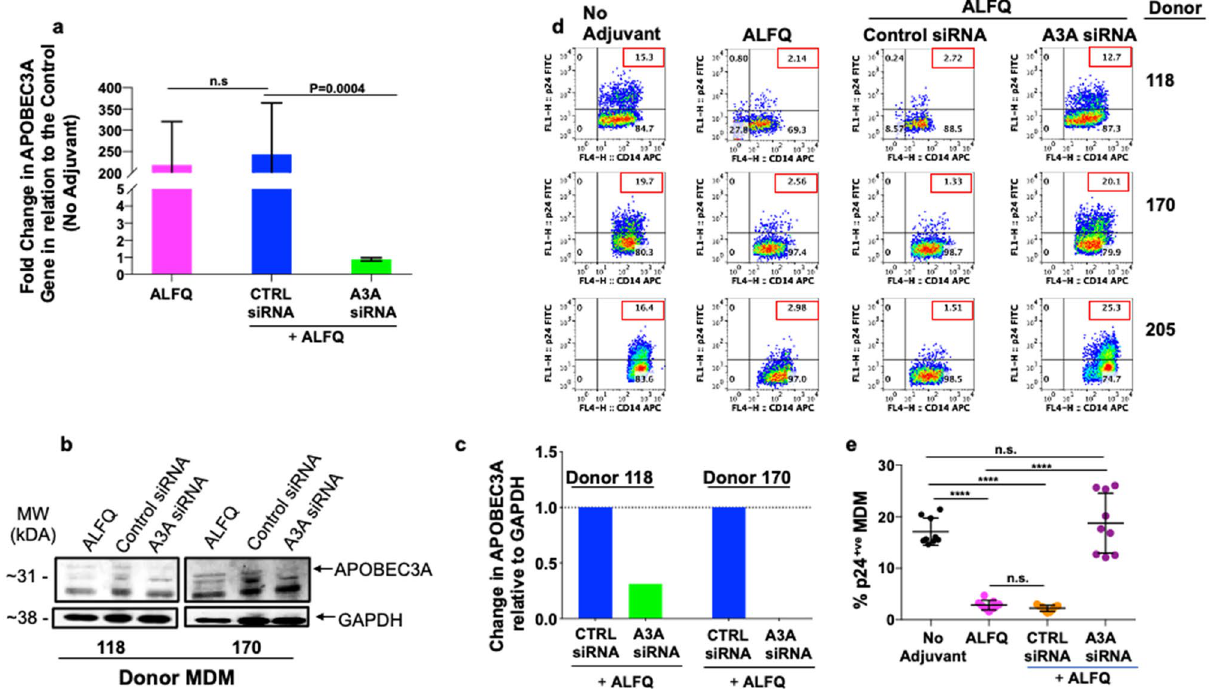
Figure 10. APOBEC3A is involved in the modulation of HIV-1 infection in ALFQ-treated MDM. Primary human monocytes were differentiated into MDM following in vitro culture with M-CSF media. At day 3, cultures were transfected with either APOBEC3A siRNA (A3A siRNA) or with scrambled siRNA (Control siRNA) for 24 h. At day 4 post-culture, the transfected cultures were treated with ALFQ for 24 h. MDM cultures that were neither transfected nor treated with ALFQ, or not transfected but treated with ALFQ at day 4 post-culture served as controls. ( a ) Cells from 3 donors were harvested, lysed and the gene expression levels of APOBEC3A were analyzed by RT-PCR. Bar graph shows fold-change (mean ± SEM) in the expression levels of APOBEC3A gene in relation to the untreated (no adjuvant) MDM controls. Data was analyzed using One-way ANOVA. ( b ) Cropped Western blotting (the upper band at 31kDA represents APOBEC3A) and ( c ) densitometry analyses show a decrease in APOBEC3A protein in the lysates of A3A siRNA cultures when compared to lysates of Control siRNA cultures. The original blot is presented in Supplementary Figs. 1–5. ( d ) Plots shows the percentage of intracellular p24 by flow cytometry at day 5 post-infection with HIV-1 in 3 donors (described in a ) either not transfected or transfected with siRNA before treatment with ALFQ. Values in the upper right quadrant(s) of the plots represent the percentage of HIV-1-infected MDM under each treatment. ( e ) Scatter dot plot represent the data from ( d ) for triplicate wells from 3 donors and show the percentage of HIV- 1-infected MDM (mean ± s.d.) in untreated MDM (black circles), MDM treated with ALFQ (magenta circles), A3AsiRNA-transfected-ALFQ-treated MDM (orange circles), and scrambled siRNA-transfected-ALFQ-treated MDM (purple circles) of triplicate wells from the 3 donors. **** P < 0.0001, One-way